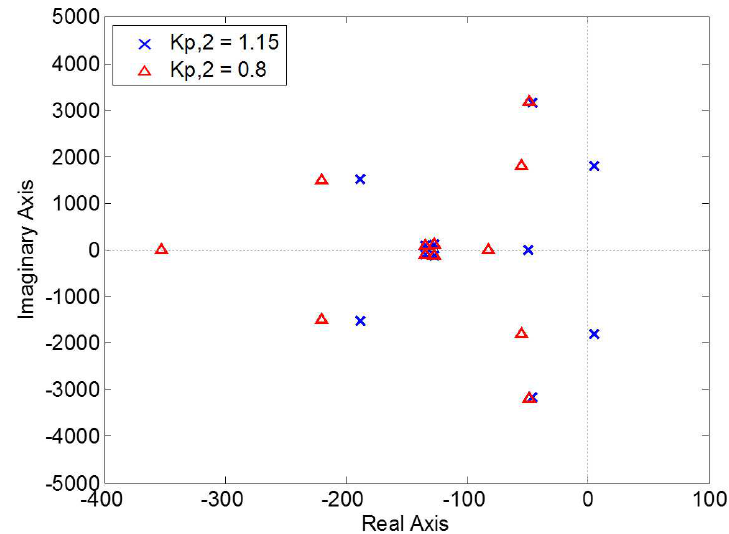
Figure 14. Poles of 1/ ( Y g + Y eq ) when the proportional gain of the additional converter parameter changes.